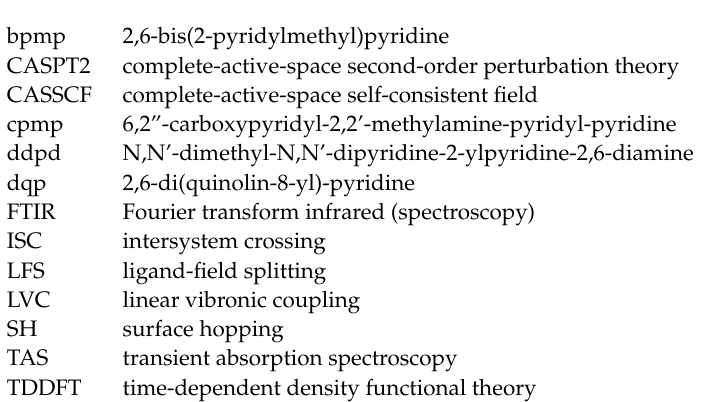
] 3+ . After ex- 2 states, the system relaxes to the 4 T 2 2 and 2 E states from where emission 1